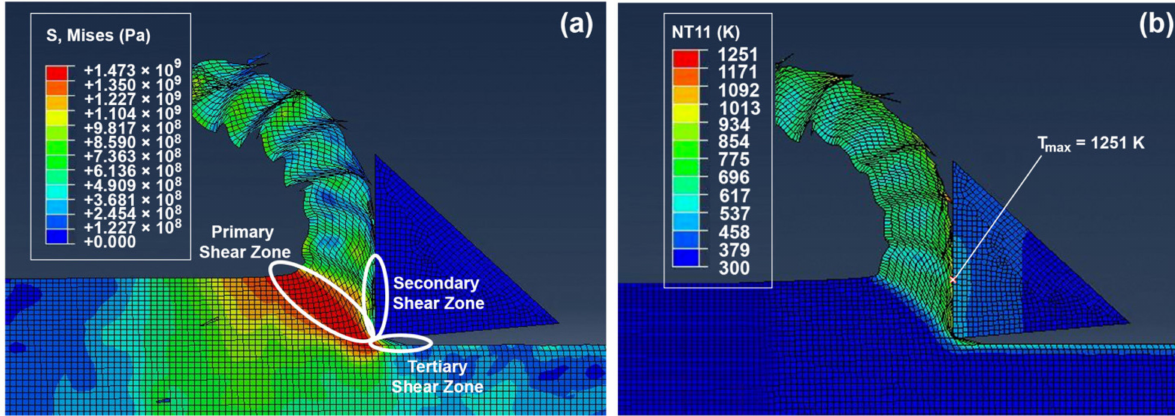
Figure 4. ( a ) Von Mises stress plot (in Pa) and ( b ) temperature profile (in